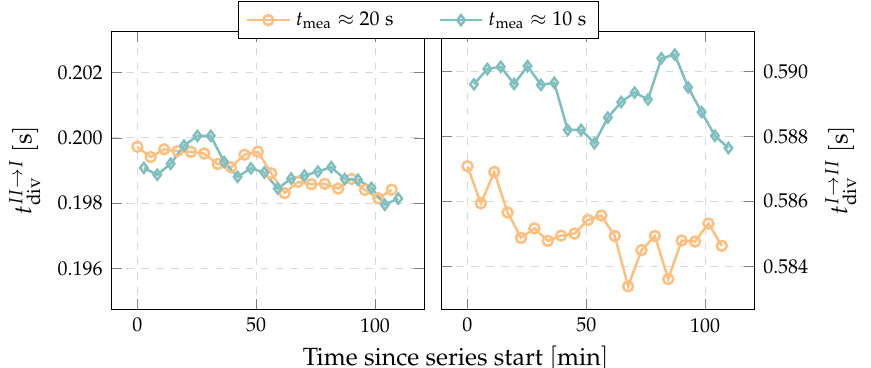
≈ 0.2 s and t I → II ≈ 0.6 s; div div